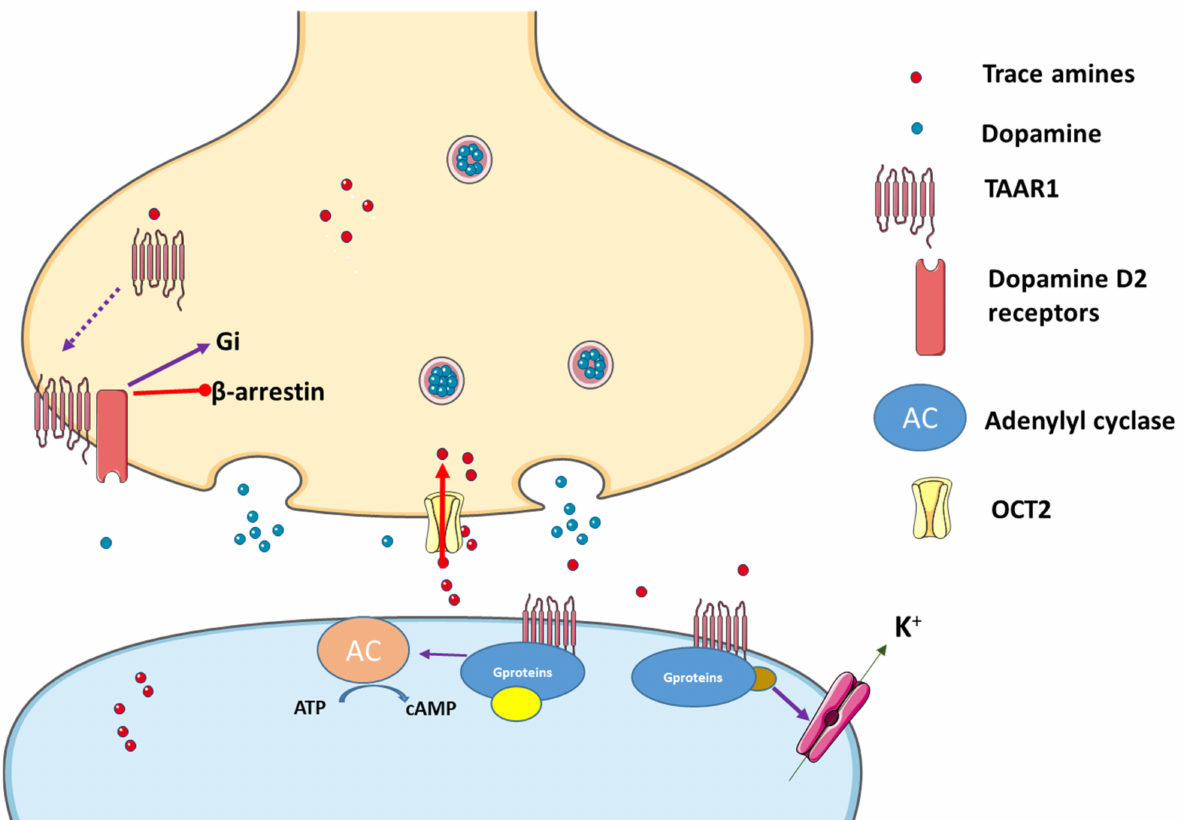
Figure 3. Trace amines activate TAAR1, leading to adenylyl cyclase (AC) activation and downstream activation of protein kinase A and protein kinase C. Interactions with the dopaminergic system can also occur and TAAR1 may translocate to the cell surface after heterodimerization with dopamine receptor 2 (D2), an effect that promotes preferential signaling related to dopamine and through the Gi signal transduction cascade, while blocking the β -arrestin 2 pathway. In addition, K+ channels can be activated in the presence of TAAR agonists. Figure built resourcing to the blocks of Servier Medical